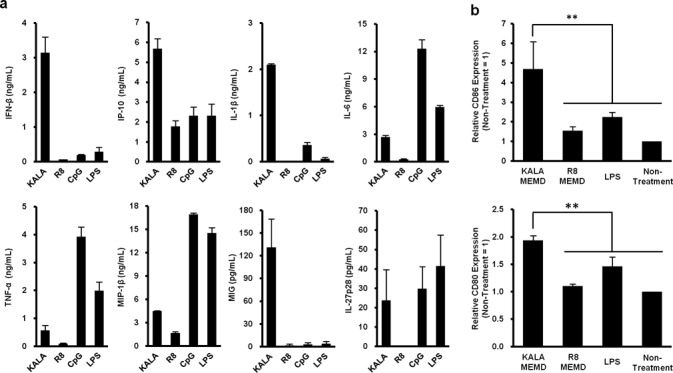
Immuno-stimulatory effect of KALA-MENDs. (a) BMDCs (4.0 × 105 cells) were transfected with the KALA- or the R8-MEND (equivalent to 0.4-μg pDNA) or exposed to LPS (100 ng/ml) or CpG ODN (1 μg/ml). After 6 h, the concentrations of several cytokines and chemokines in the supernatant were determined by ELISA. Data are the mean ± SD of three independent experiments. (b) BMDCs (8.0 × 105 cells) were transfected with the KALA- or the R8-MEND (equivalent to 0.4-μg pDNA) or exposed to LPS (100 ng/ml). After 21 h, the BMDCs (5.0 × 105 cells) were stained by PE-labeled anti-mouse CD80 and CD86. Data are the means ± SD of three independent experiments. Statistical analyses were performed by the one-way ANOVA, followed by Bonferroni test. **P < 0.01 versus KALA MEND.